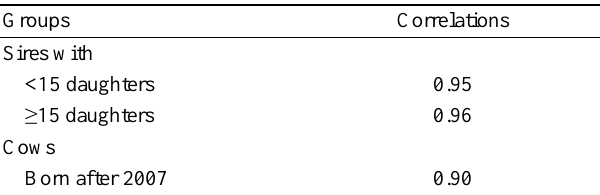
Table 5. Correlations between estimated breeding values from lactation average and random regression test-day models for groups of sires and